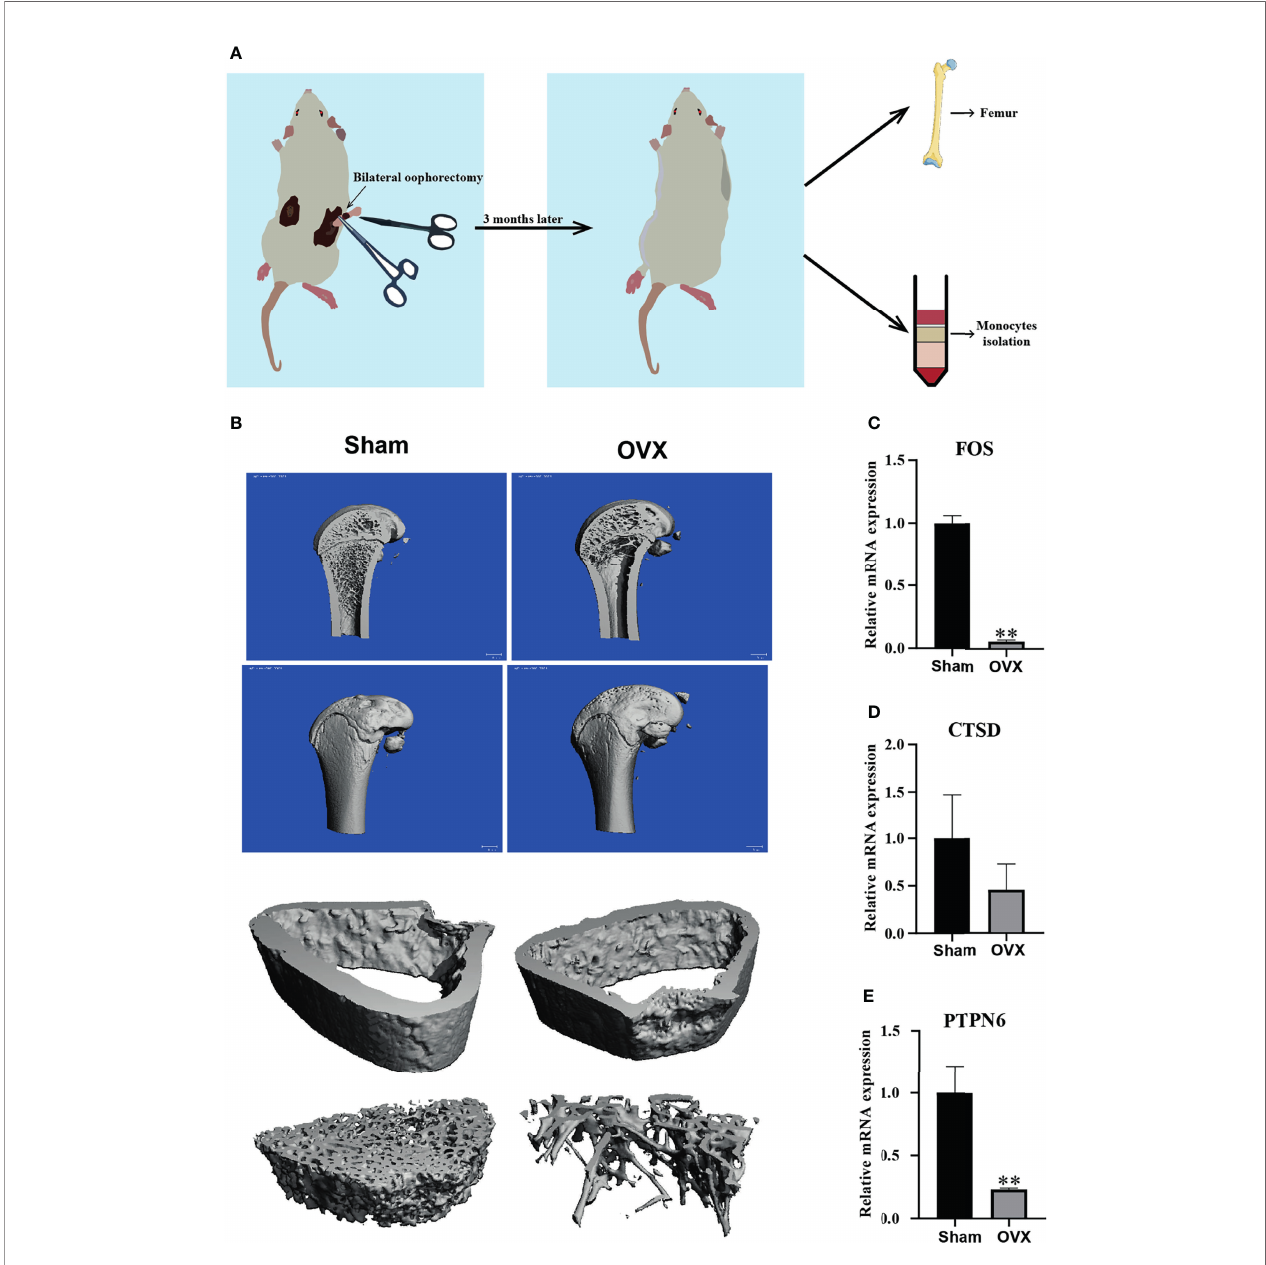
FIGURE 7 | Validation of the hub genes in vivo . (A) A diagram exhibited how we validate our results of hub genes. (B) Representative m -CT analysis image of SD rat femur in sham and OVX group, and femur 1.5 mm thick below the growth plate was used for analysis of bone cortex and cancellous bone. (C – E) The mRNA expression level of three hub genes (FOS, CTSD, and PTPN6) in sham group and OVX group. Compared with the Sham group, **p <